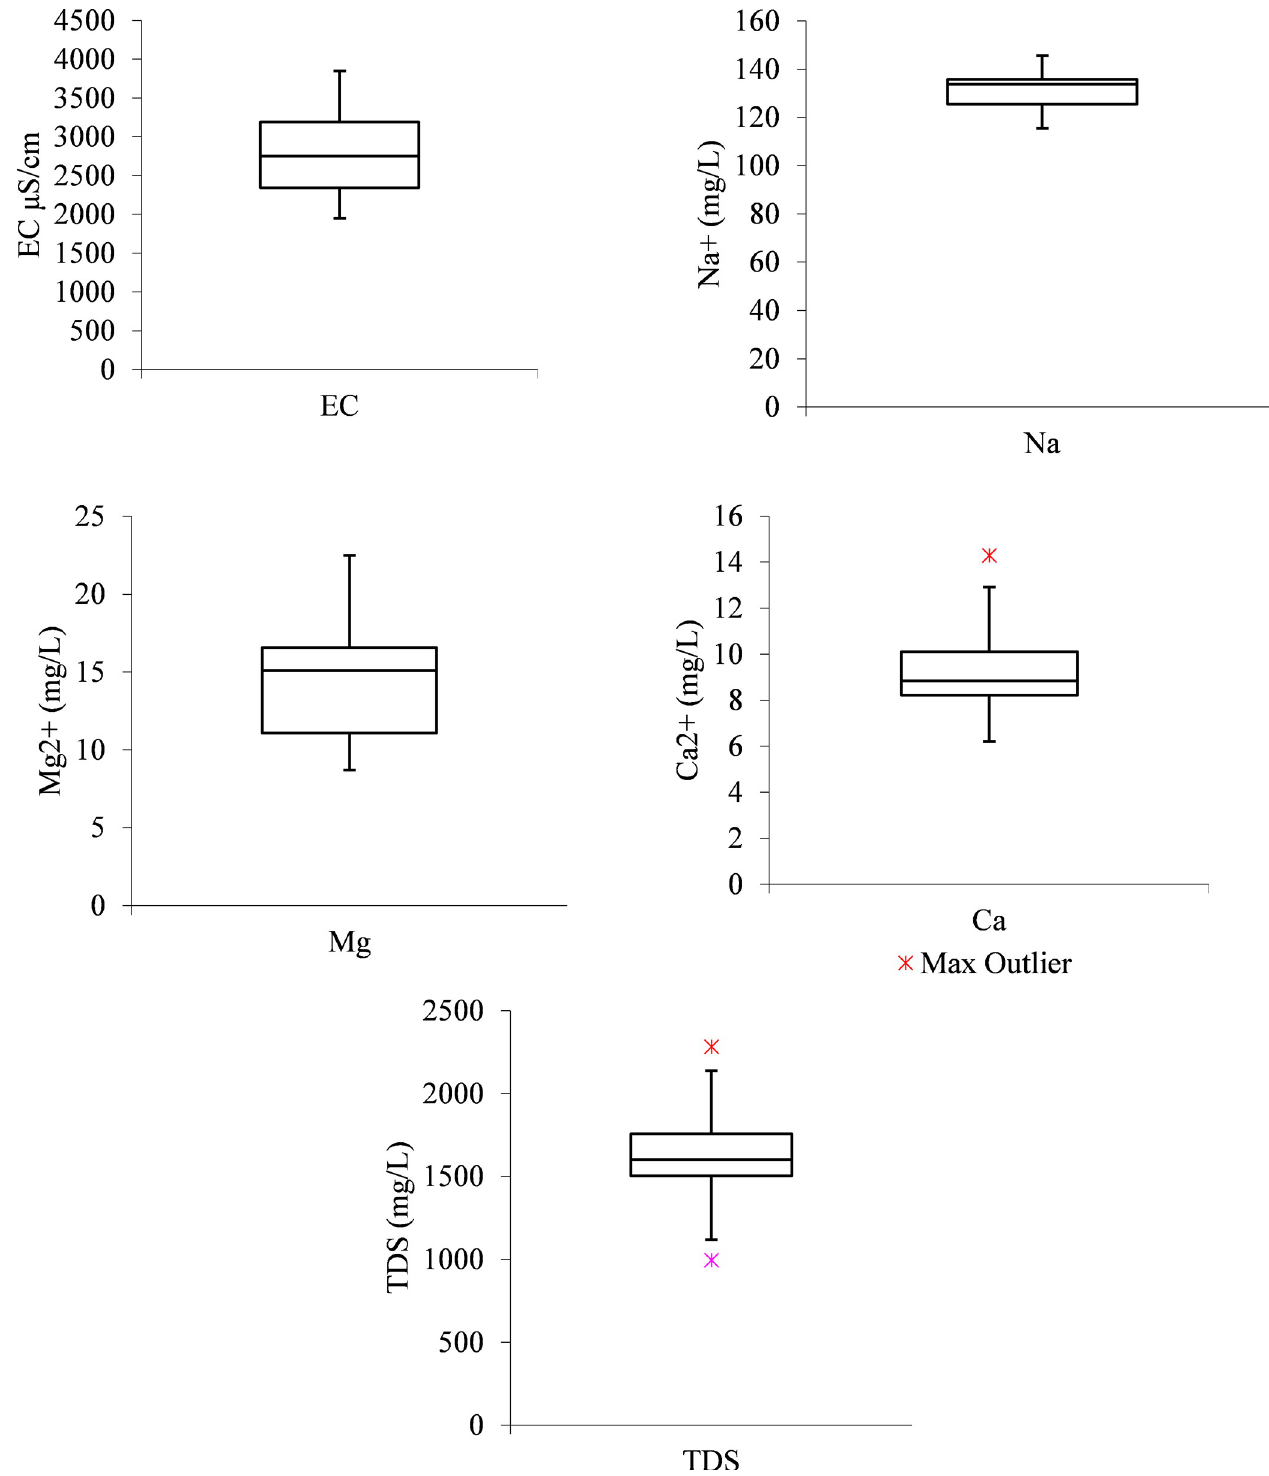
Fig 2. Boxplots from raw wastewater (a) EC (b) Na + (c) Mg 2+ (d) Ca 2+ (e) TDS.